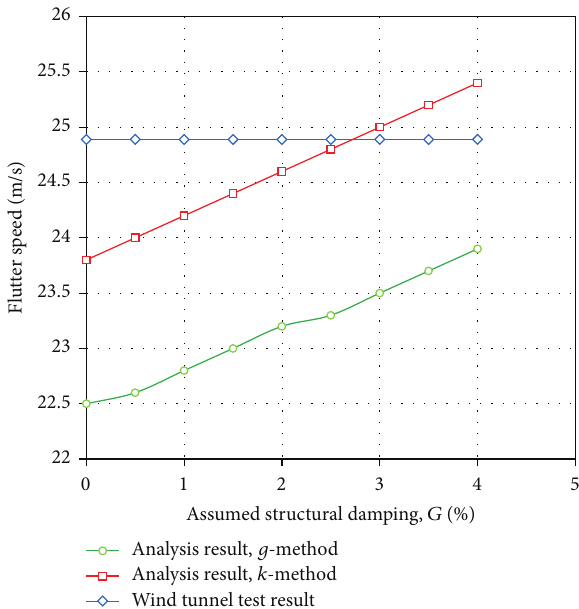
Figure 9: Flutter speed comparison between test and analysis result versus assumed structural damping.